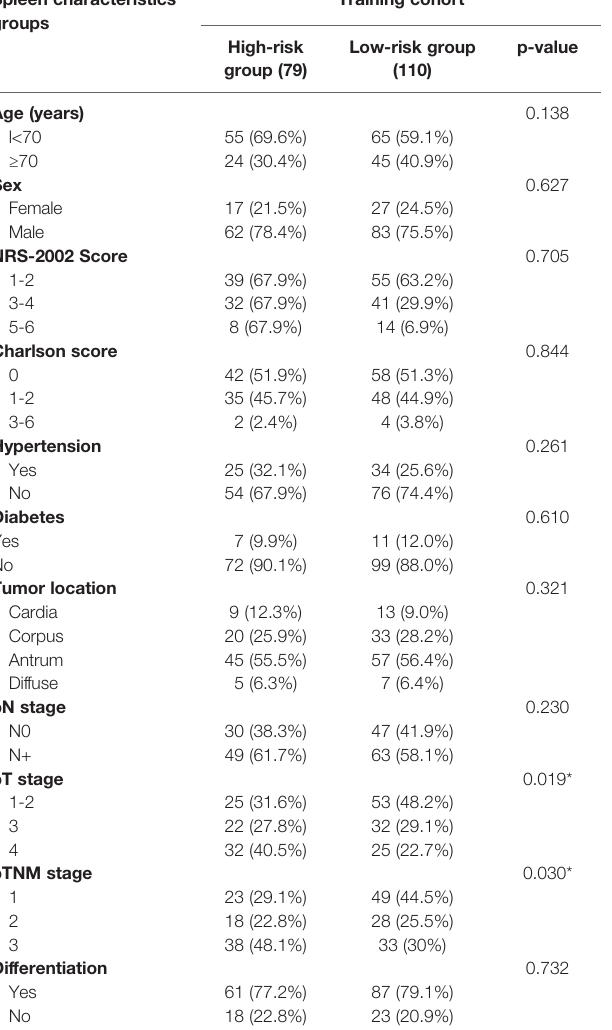
TABLE 2 | Clinical data table of radiologic tumor invasion score grouping. Spleen characteristics groups